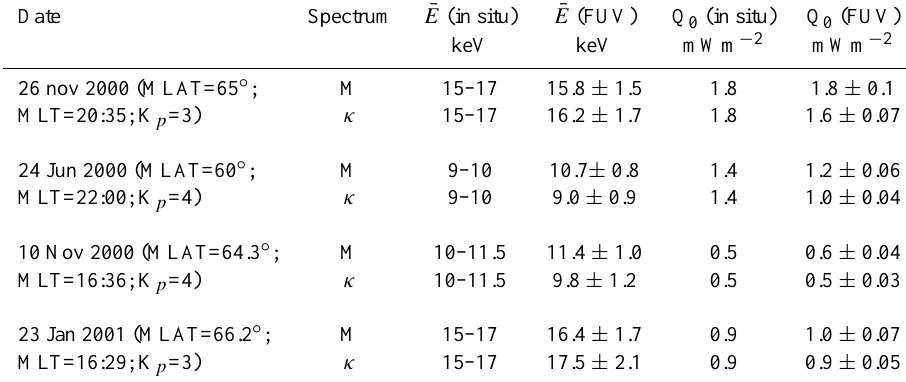
Table 1. Energy flux and average energy of proton-dominated structures: comparison between IMAGE-FUV and in situ determinations